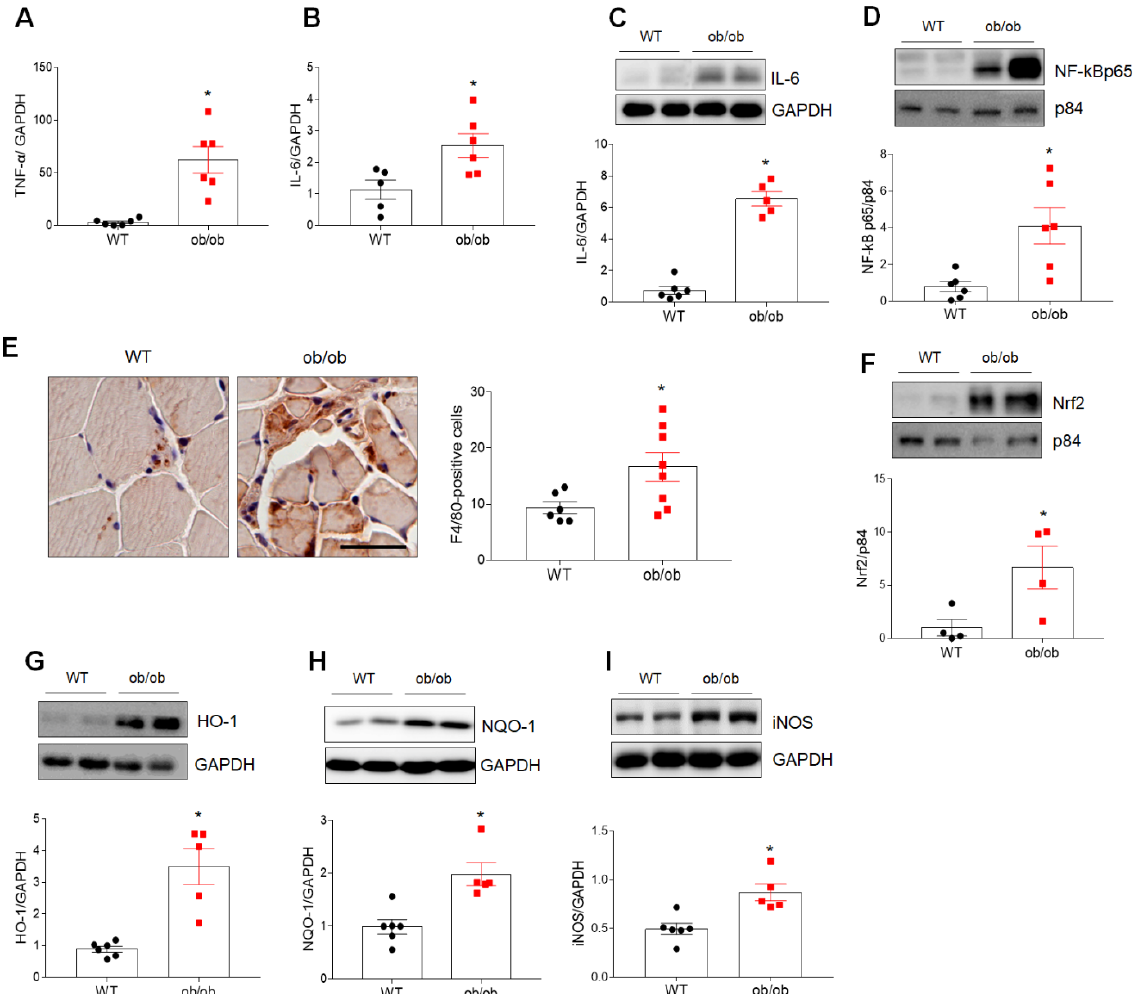
Figure 2. Obese sarcopenia is associated with inflammation and oxidative stress in ob/ob mice. ( A , B ) Quantitative RT-PCR analysis of TNF-α ( A ) and IL-6 ( B ) gene expression in the skeletal muscle of wild-type (WT) and ob/ob mice. ( C , D ) Western blotting and quantitative analysis of IL-6 ( C ) and NF-κBp65 ( D ) expressions. ( E ) Representative images of immunostaining of F4/80 in cross-sections of skeletal muscle. The chart shows the number of F4/80-positive cells in F4/80-immunostained skeletal muscle sections. Scale bar = 50 µ m. ( F – I ) Western blotting and quantitative analysis of Nrf2 ( F ), HO-1 ( G ), NQO-1 ( H ), and iNOS ( I ) expressions. GAPDH or p84 was used as an internal control to normalize total or nuclear protein levels, respectively. Data are shown as the mean ± SEM. * p < 0.05 vs. WT